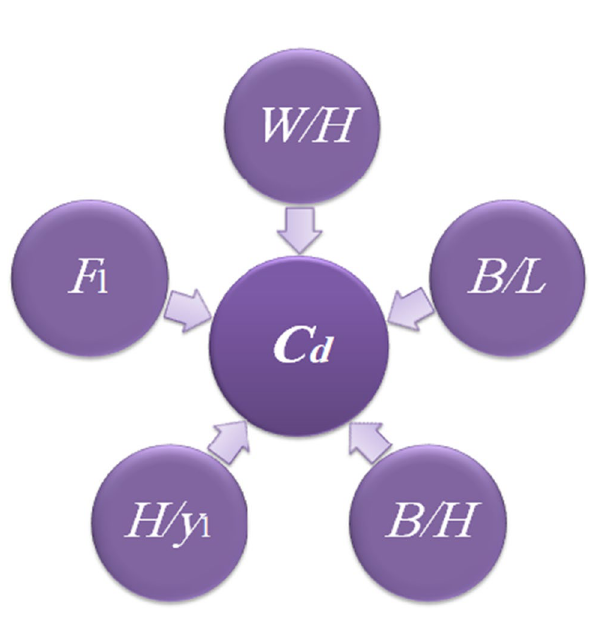
Fig. 3 Layout of experimental model used in study